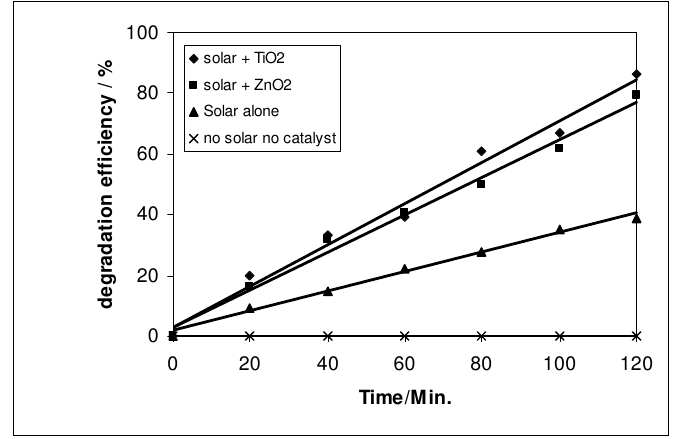
Figure 2. Degradation of TB under different conditions